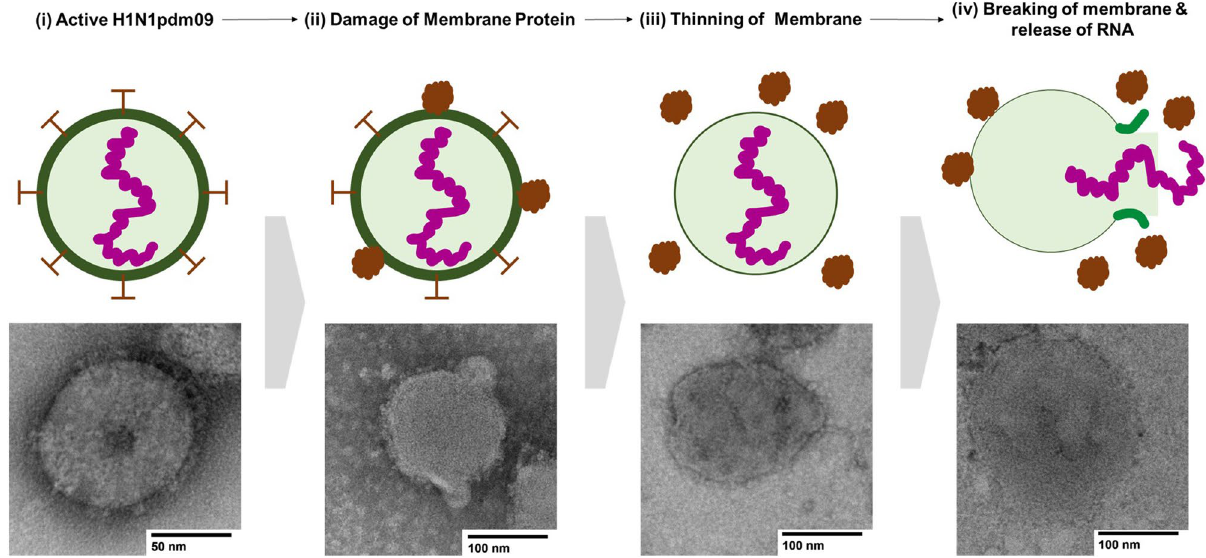
Figure 8. Suggested photothermal inactivation mechanism of the pandemic H1N1pdm09